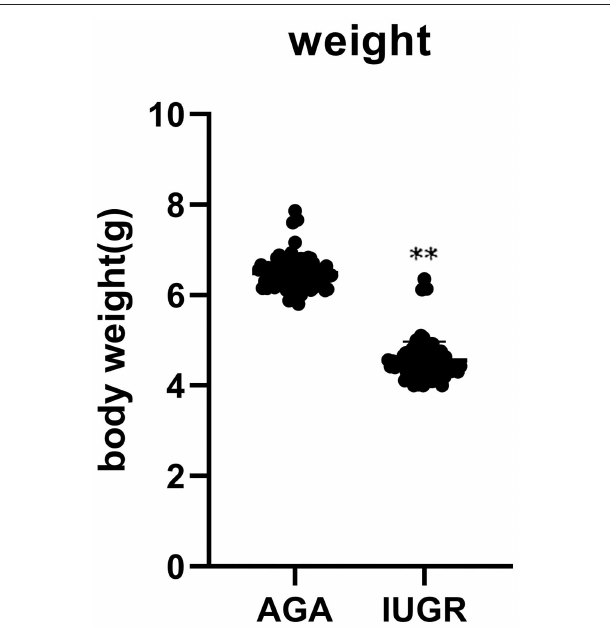
FIGURE 1 | The body weight of 85 AGA (6.49 ± 0.35) and 80 IUGR (4.55 ± 0.42) rats at 1 day (** P < 0.01).